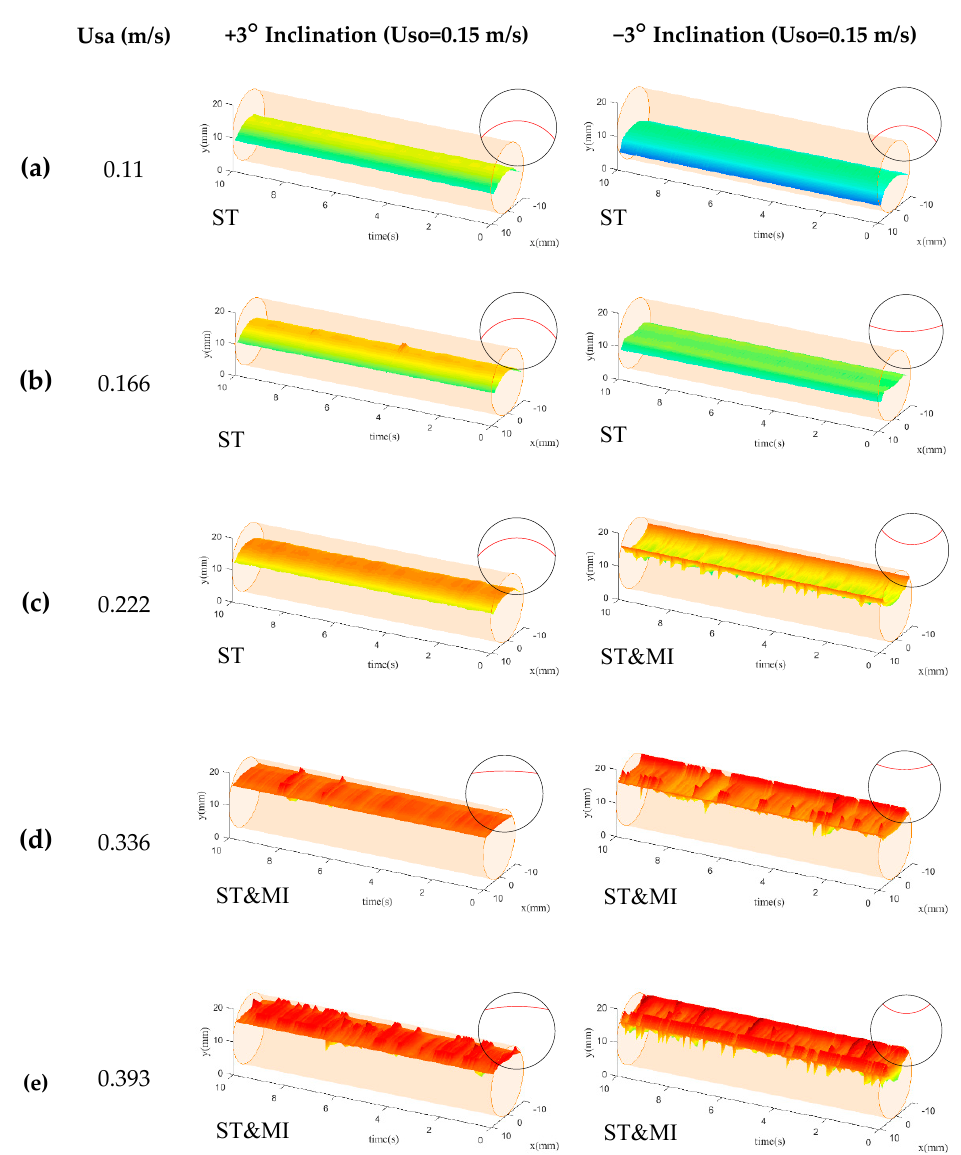
Figure 14. CPAP visualizations of the liquid-liquid interfaces for Uso = 0.15 m / s: ( a ) Usa = 0.11 m / s; ( b ) Usa = 0.166 m / s; ( c ) Usa = 0.222 m / s; ( d ) Usa = 0.336 m / s; ( e ) Usa = 0.393 m / s.